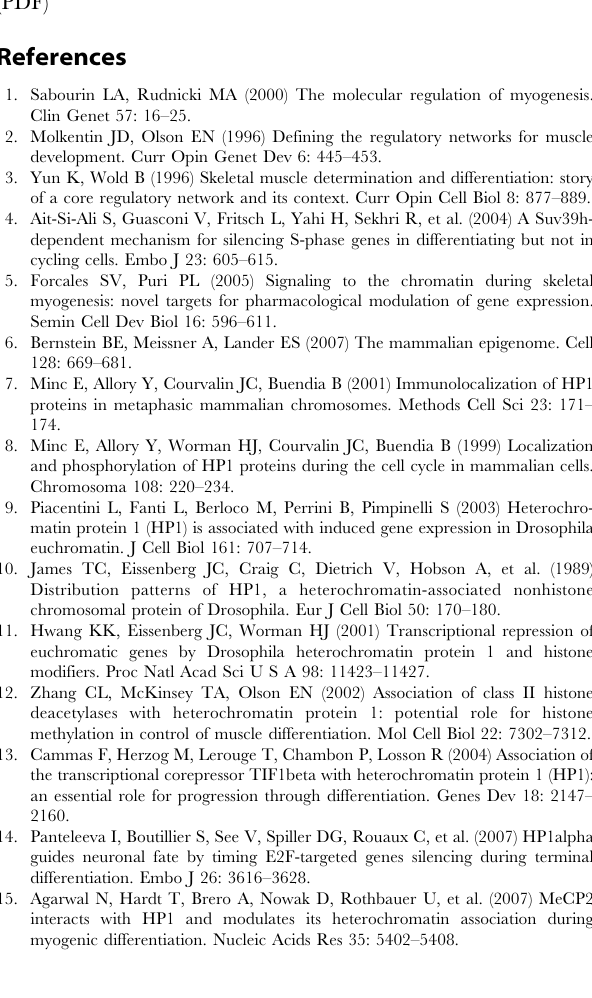
Figure S4 C2C12 cells were transfected with nonspecific siRNA (siNA) or HP1 a siRNA (siHP1 a ). 48 hours after transfection Chip assay was performed with anti-H3K9me3 (A) or anti-JHDM3A antibody (B). H3K9me3 levels (A) and presence of JHDM3A (B) at Lbx1 exon 2 were quantified by Real time PCR. *P , 0.01 for siNS transfected cells versus siHP1 a transfected cells. (PDF) Figure S5 A. C2C12 cells were transfected with nonspecific siRN or JHDM3AsiRNA. Total RNA was isolated at indicated time points after transfection. Semiquantitative PCR analysis of gene expression was performed. B. Western blotting was performed with indicated antibodies on whole proteins extracted from C2C12 myoblasts (MB) and myotubes (MT).